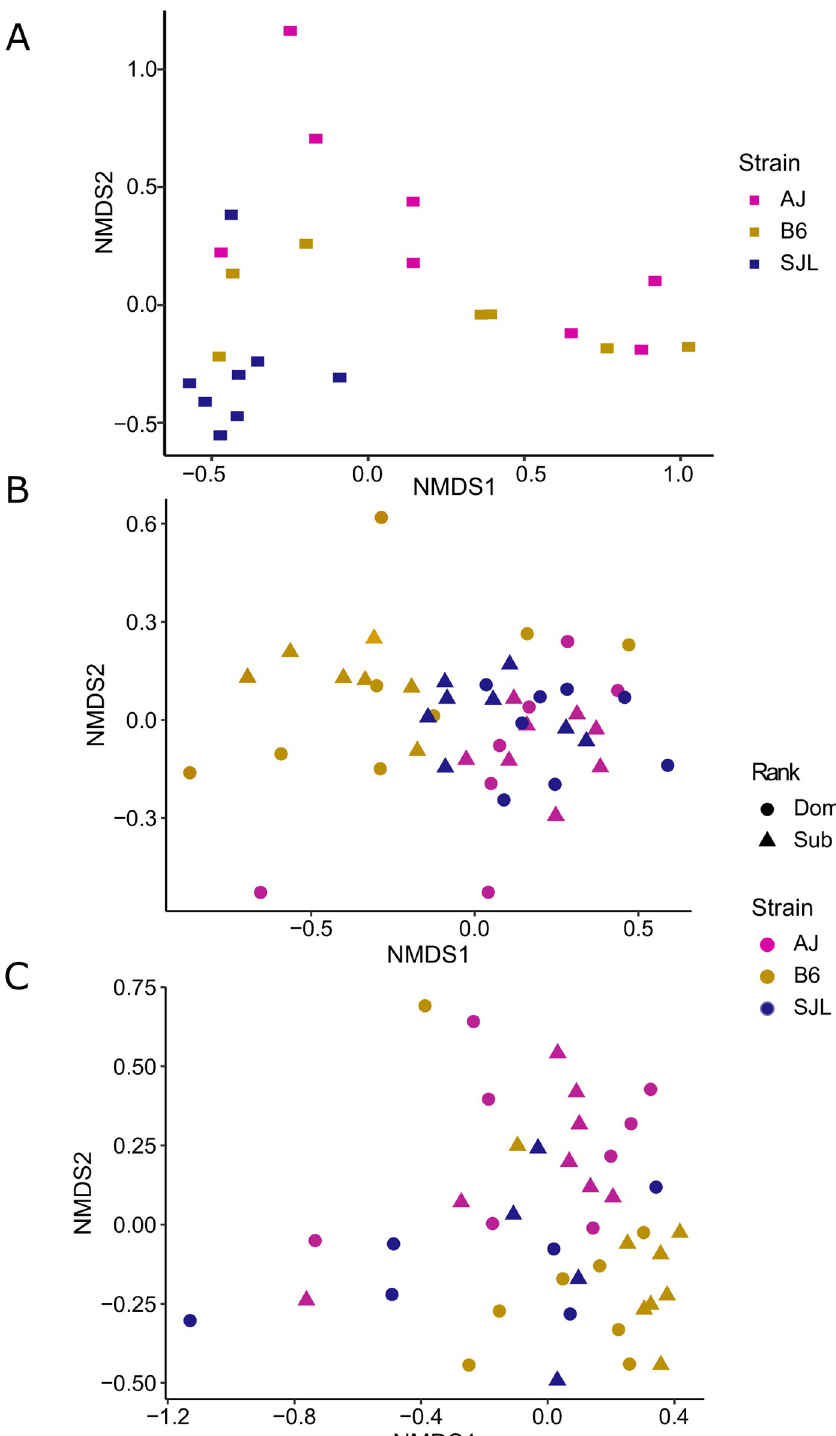
Fig 2. Volatile organic compound profiles of (A) nesting material, (B) plantar sweat, and (C) urine showed strain specific patterns. Non-metric multidimensional scaling using Bray-Curtis dissimilarity matrices for (A) used nesting material (stress = 0.095, N = 23), (B) plantar sweat (stress = 0.113, N = 46), and (C) urine (stress = 0.162, N = 42) showed sample separation corresponding to strain. Multivariate analyses using the Adonis test showed a significant difference in profiles between strains for all sample types: nest, p = 0.006; sweat, p = 0.001; and urine, p = 0.001. In